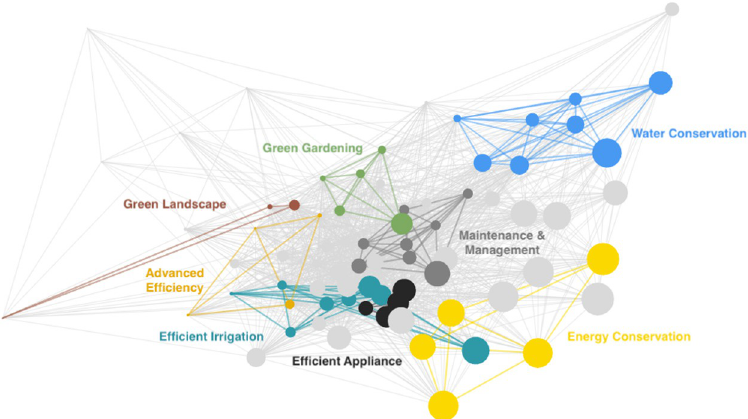
Fig 2. Network analysis depicting correlations among self-reported household energy- and water-saving measures.